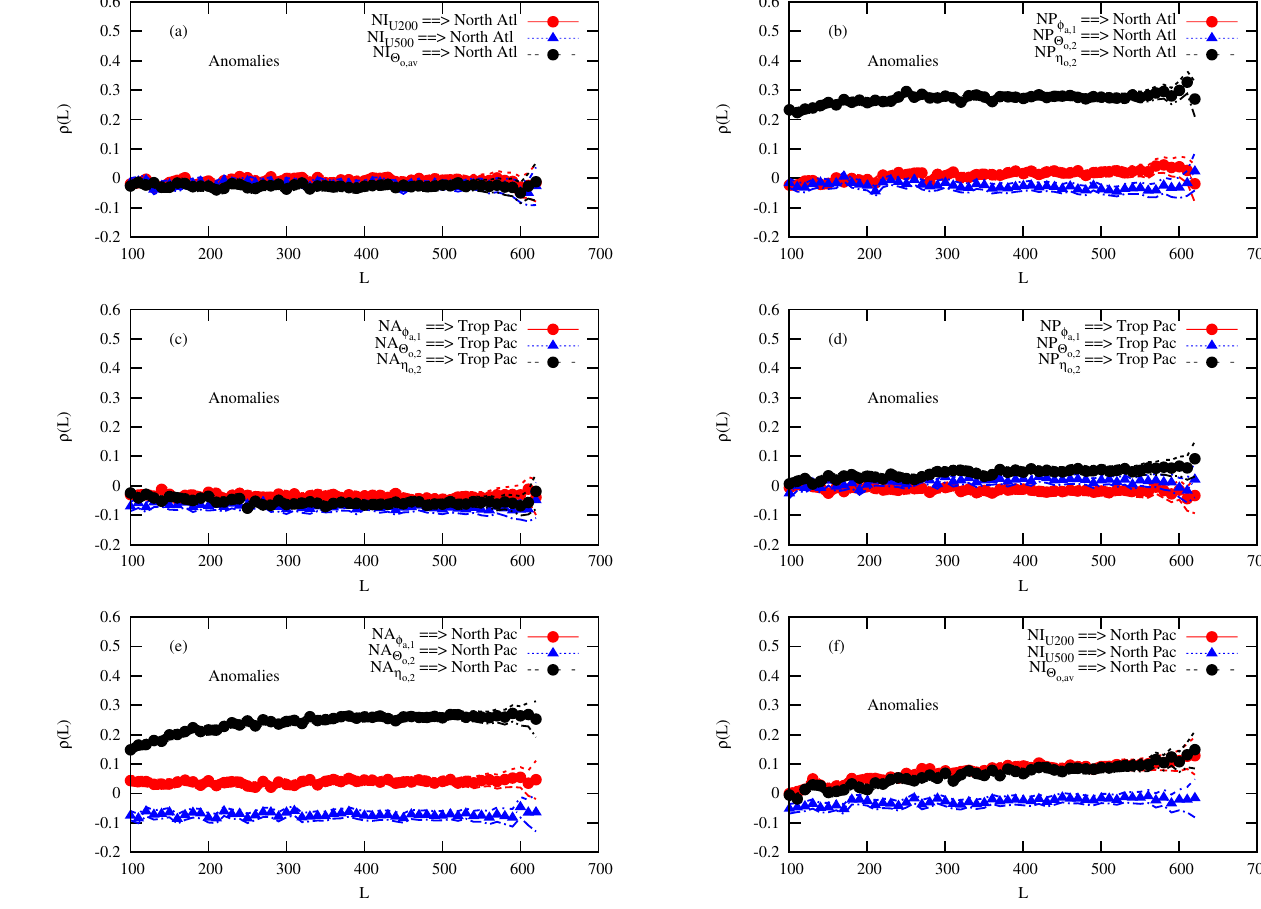
Figure C1. CCM as a function of the size L of the samples, as obtained from the anomaly of the monthly time series displayed in Fig. 1 for the ERA-20C and ORA-20C reanalyses. Each line with symbols corresponds to the influence of one variable on a specific coupled ocean–atmosphere basin. The specific variables are denoted in the caption corresponding to each line in each